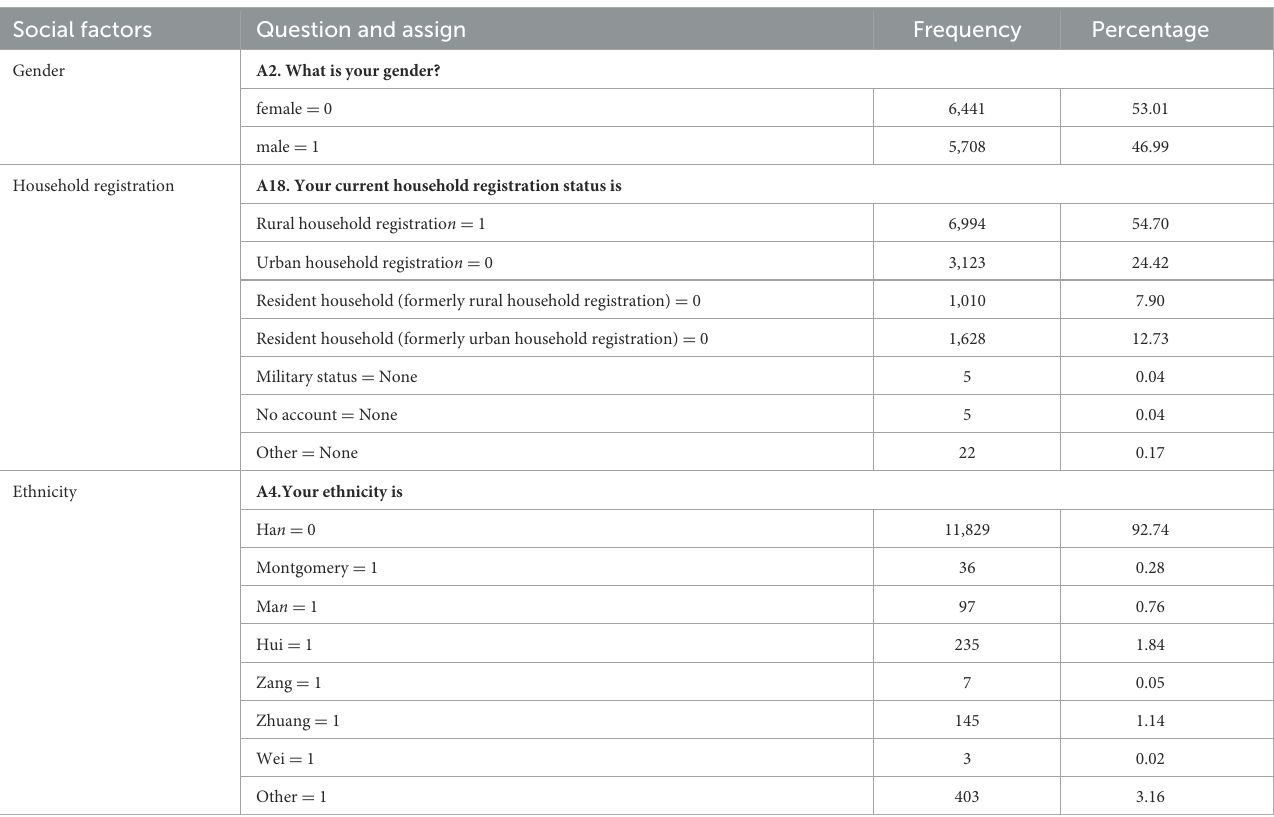
TABLE 2 The measurement of the independent variable—social factors (CGSS